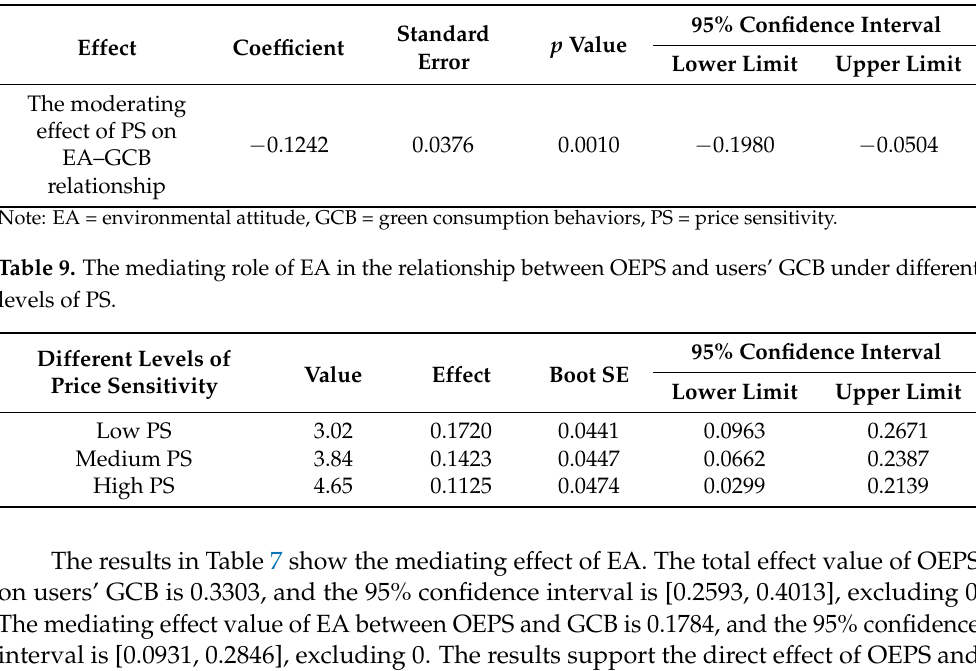
Table 8. The moderating effect of price sensitivity on environmental attitude–green consumption behaviors relationship.